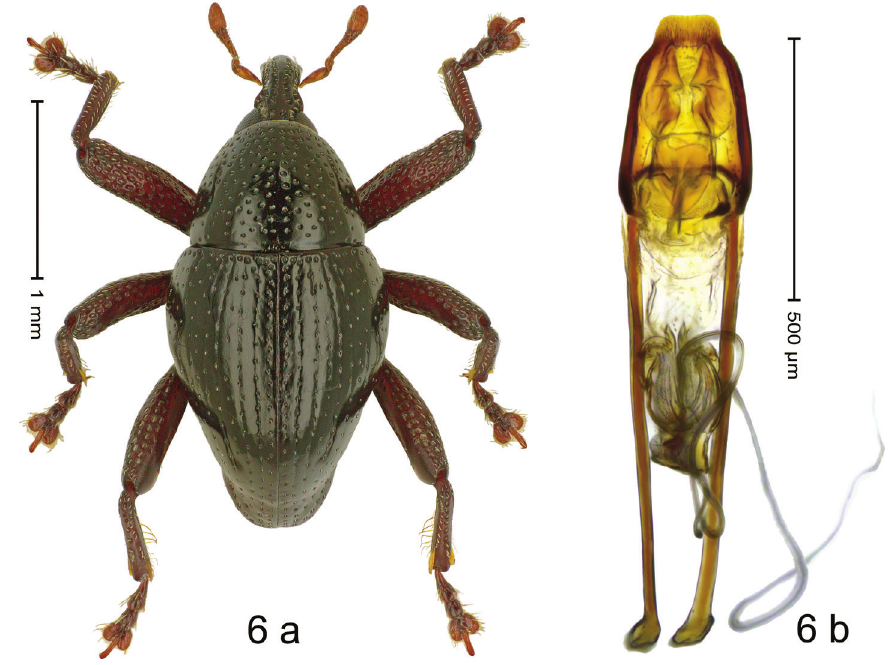
Figure 6. Trigonopterus daun sp. nov., holotype a habitus b penis.